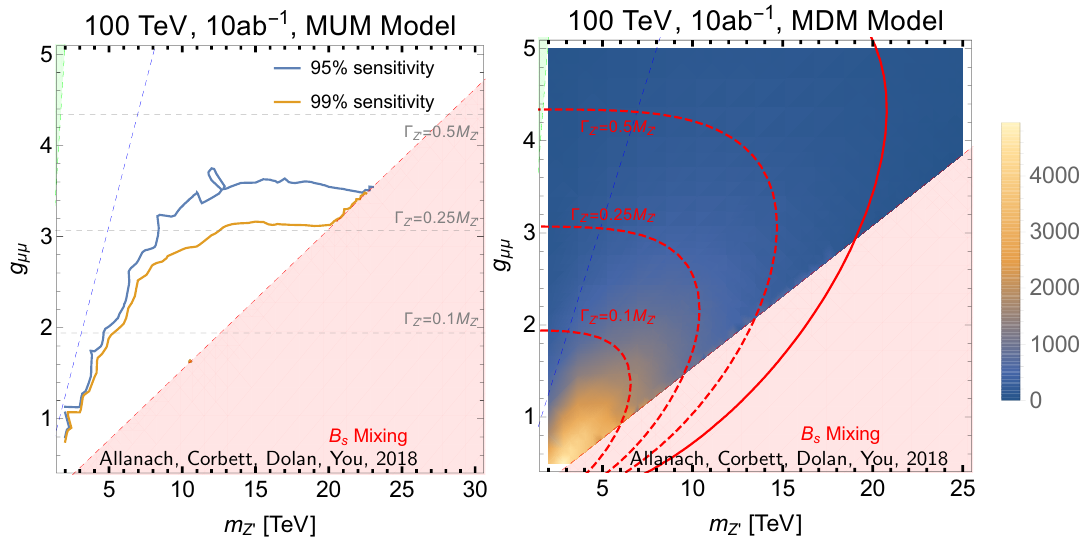
Figure 10 . Predicted sensitivity for the 100 TeV FCC with 10/ab integrated luminosity in the M Z 0 { g (cid:22)(cid:22) plane for the MUM model (left). Each point in the plane (cid:12)ts the neutral current B - anomalies, since eq. (2.2) with x = 1 : 00 has been enforced meaning that g bs / M 2 solid lines in the left-hand panel show the regions of 95% CL and 99% CL sensitivity being below each contour. In order to show more of the parameter space, we have displayed the pre-2016 B s mixing constraint in pink and the one based on eq. (2.3), where the region below the blue dashed line is ruled out. The grey dashed lines show contours of the relative decay width (cid:0) Z 0 =M Z 0 . The MDM model’s signi(cid:12)cance S is colour-coded with the legend on the right; its sensitivity is S > 10 (cid:27) everywhere on the plane